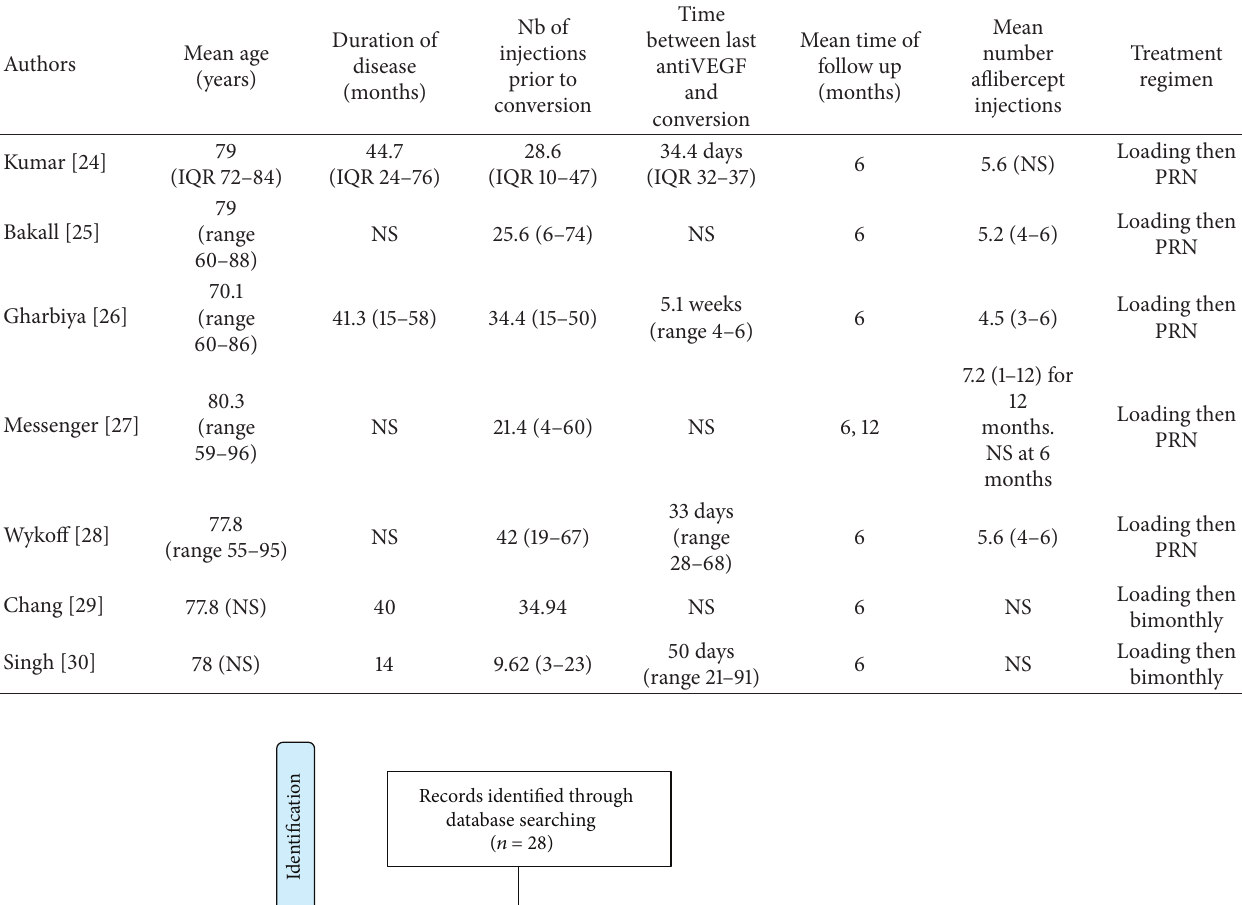
Table 2: Clinical characteristics of all studies included in the Meta-analysis.